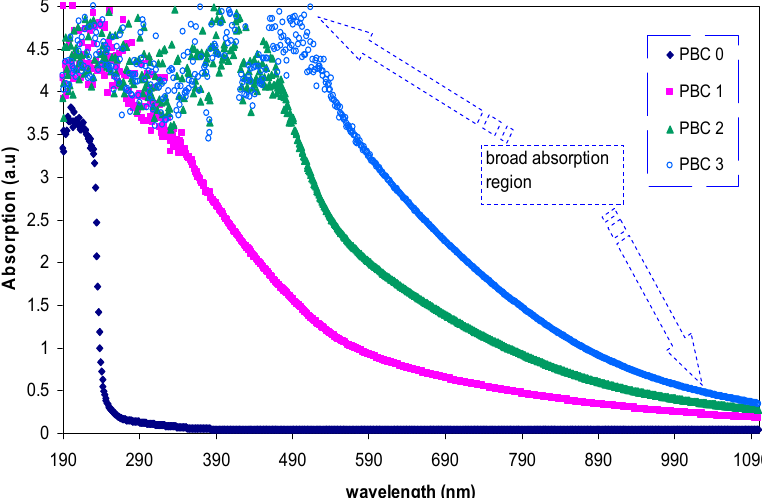
Figure 16. Optical absorption versus wavelength for pure PVA/PVP and PVA/PVP doped with various molar ratios of Ag 2 S semiconductor particles [144].